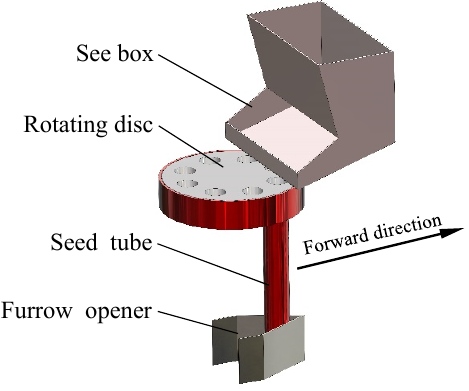
Figure 9. Revolving disc seed metering device.